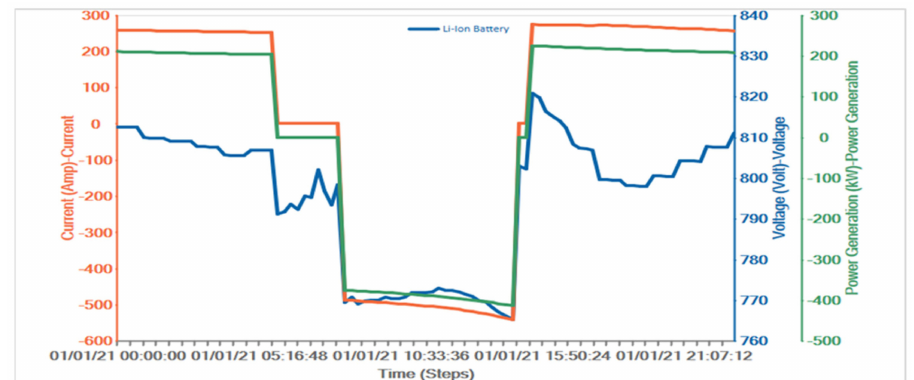
Figure 18. Lithium-ion combined